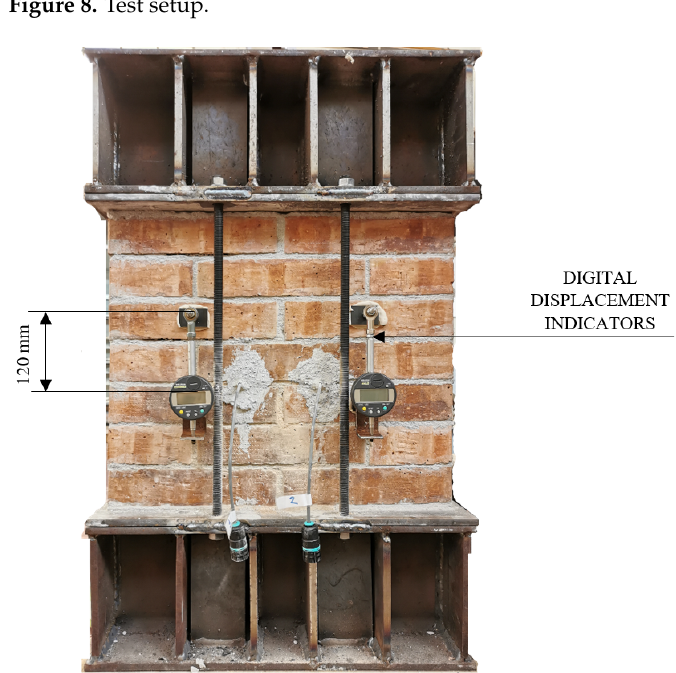
Figure 9. Placement of digital absolute displacement